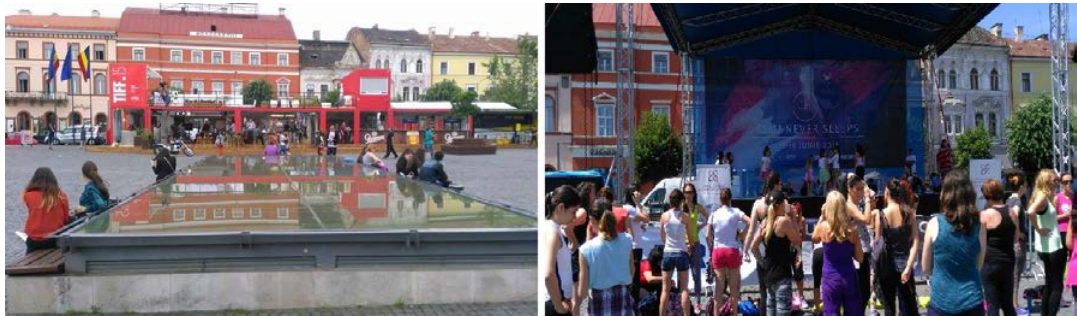
Figure 14: Transylvania International Film Festival location in the Union Square / Dance show at Cluj Never Sleeps event Source: Emanuel- Cristian ADOREAN,